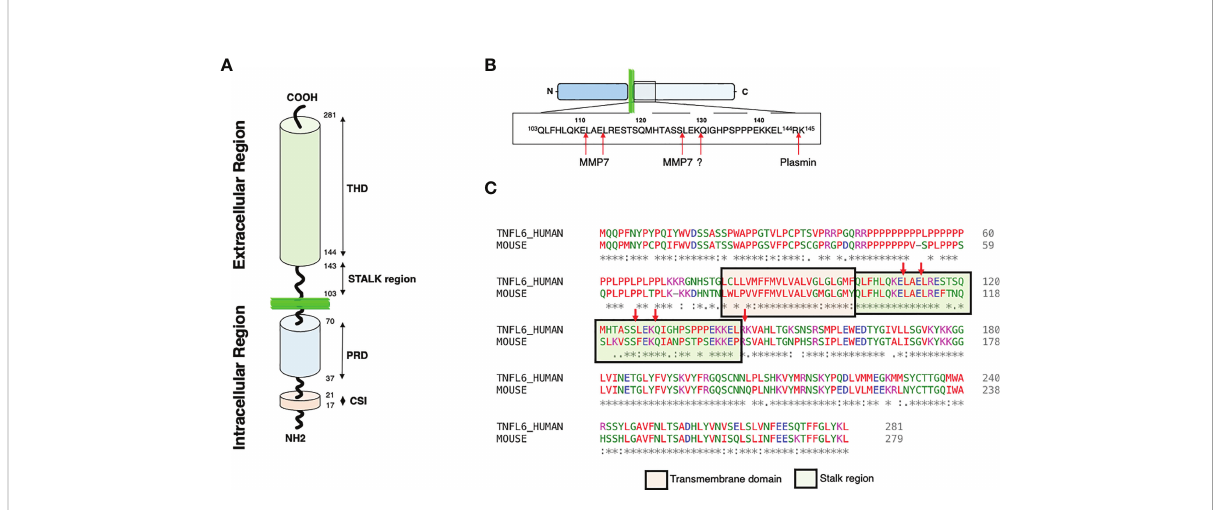
FIGURE 1 CD95L structures and cleavages sites. (A) Representation of CD95L domains. Proline rich domain: PRD; Casein kinase I substrate motif: CSI; TNF homology domain: THD. (B) Representation of the different cleavage sites described within the CD95L stalk region. (C) Alignment of human and mouse CD95L protein sequence using Clustal omega (1.2.4). The transmembrane and the stalk domains are